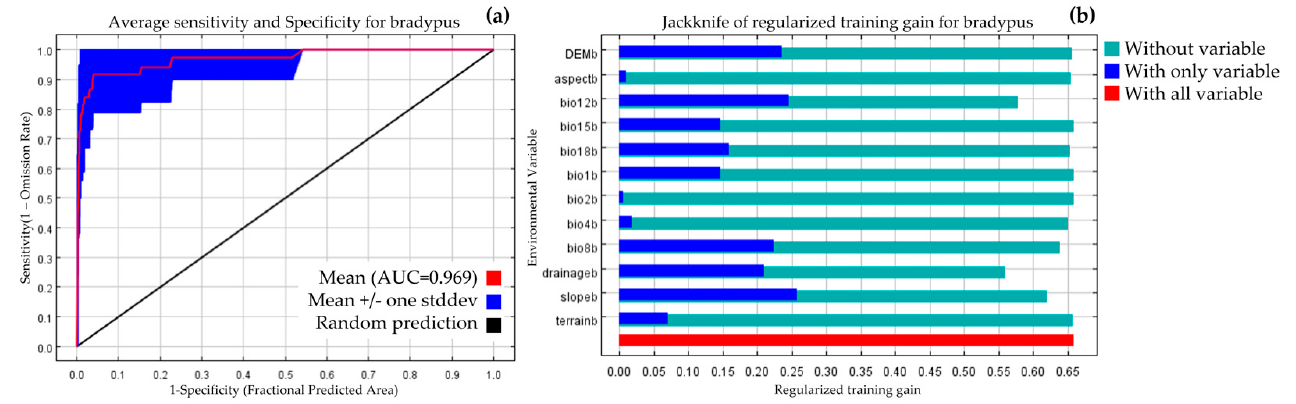
Figure A3. The receiver operating characteristic (ROC) curve of Q. acuta ( a ); the Jackknife tests the importance of the training of variables to distribution of Q. acuta ( b ).